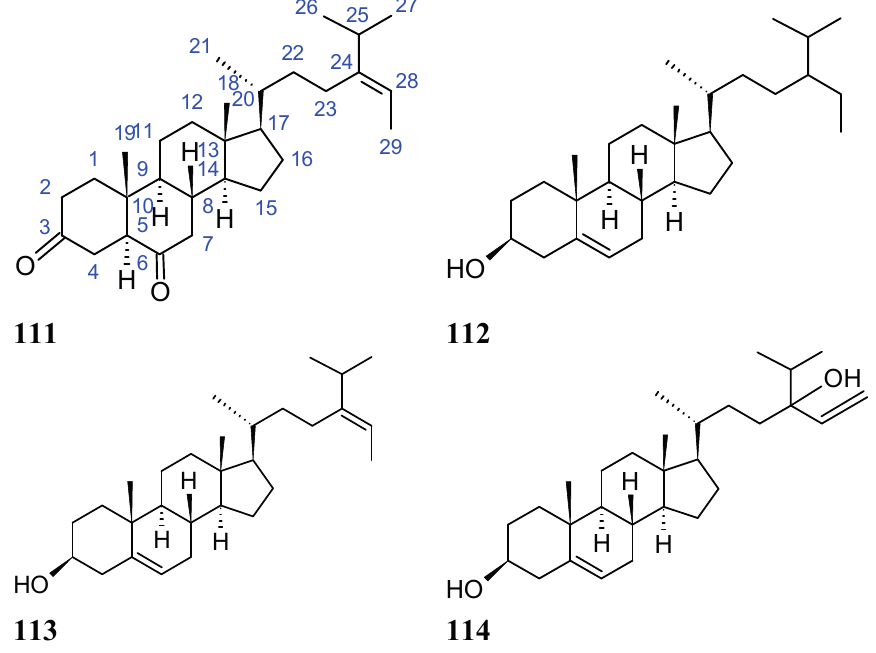
Figure 38. Diketosteroid, ( E )-stigmasta-24(28)-en-3,6-dione ( 111 ), β -sitosterol ( 112 ), fucosterol ( 113 ) and saringosterol ( 114